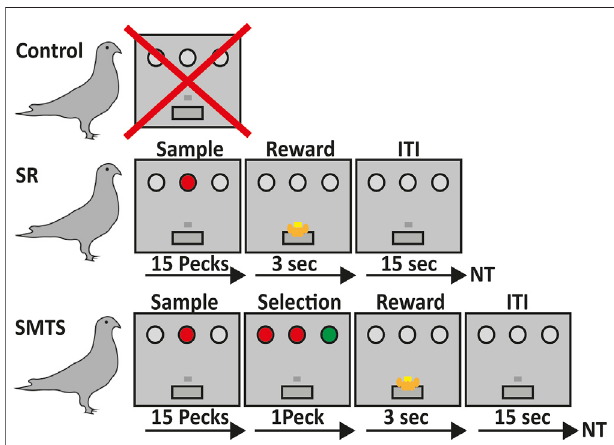
FIGURE 1 | Overview of the learning paradigms for the three pigeon groups. Birds in the control group did not participate in any operant task (line 1). Pigeons of the stimulus-response (SR)-group were trained to associate a stimulus with a reward after 15 pecks on either a red or green operant key on one of the three positions at the back wall of the Skinner box, which wasthen rewarded for3 swithaccess to food via afoodhopper.Afterthat an intertrial interval (ITI) of 15 s began before the next trial (NT) started (line 2). In the simultaneous-matching-to-sample (SMTS)-grouppigeons were trained to peck 15 times on the either red or green illuminated center key. Afterwards a choice period started, during which they had to select the lateral key that matched the sample color. During this phase all keys were simultaneously illuminated so that the birds were able to compare the stimuli and decide. Selection of the correct response resulted into 3 s access to food that was followed by an ITI of 15 s before the NT started (line 3).